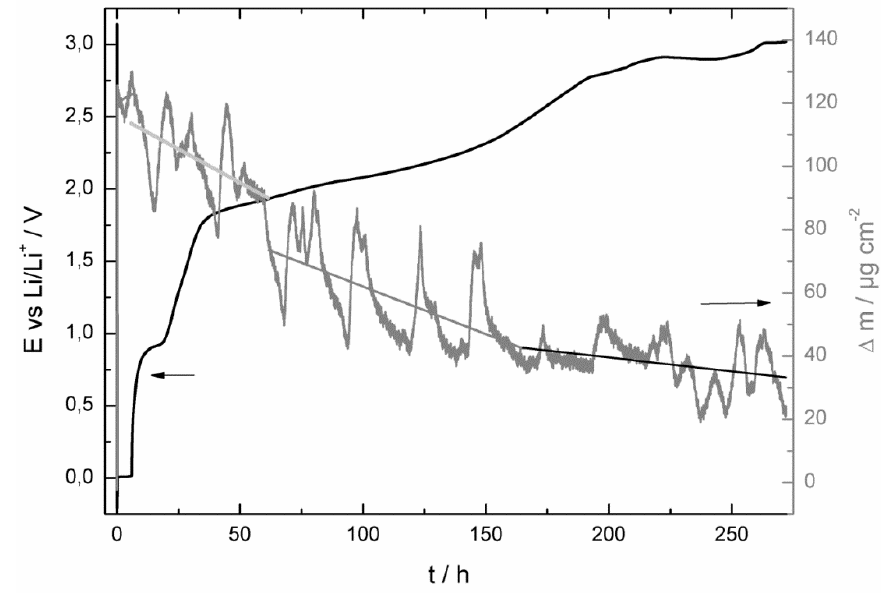
Figure 1. Time dependence of potential and attributed mass change during the OCP